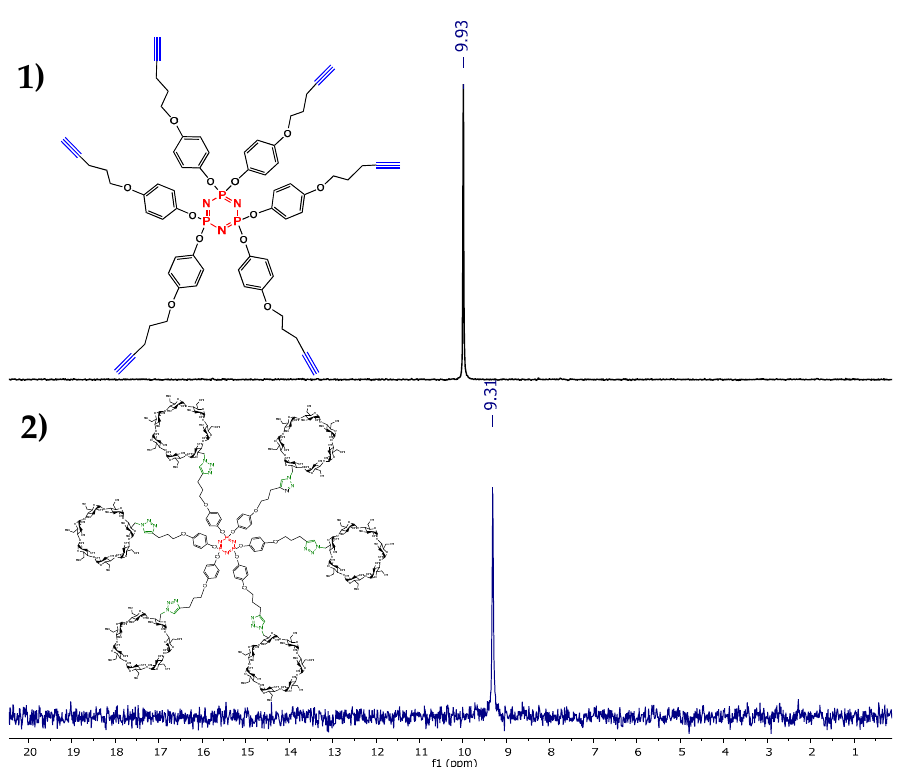
Figure 3. Split of 31 P-NMR in DMSO- d 6 of ( 1 ) P 3 N 3 -[ O -C 6 H 4 - O -(CH 2 ) 3 -alkyne] 6 (compound C ) and ( 2 ) P 3 N 3 -[ O -C 6 H 4 - O -(CH 2 ) 3 - β CD] 6 (PDC G ).